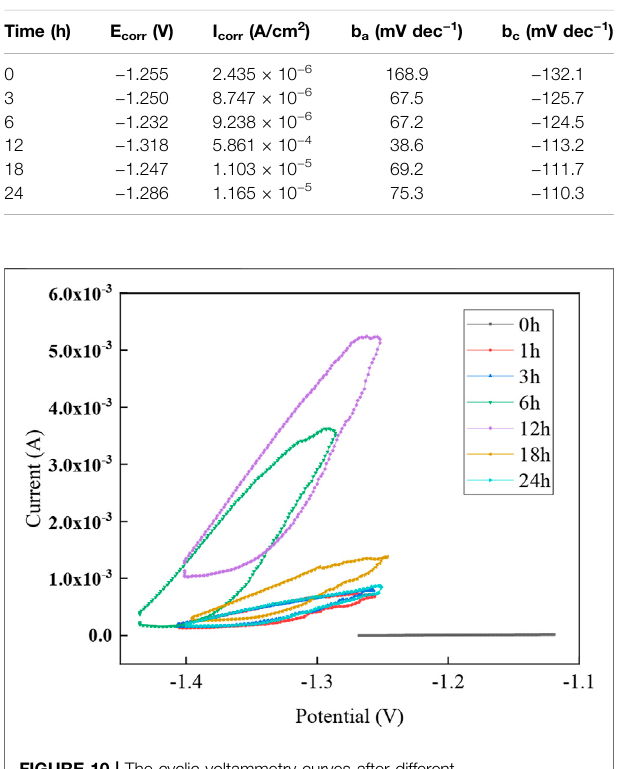
Frontiers in Materials |